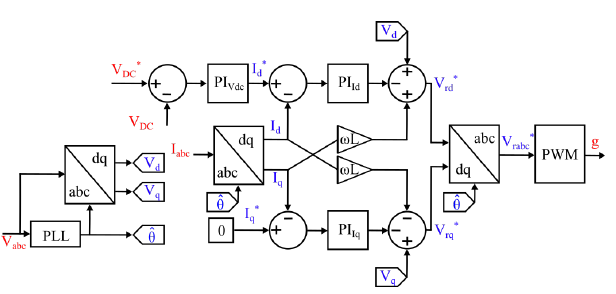
Figure 25. Voltage oriented control of AFE